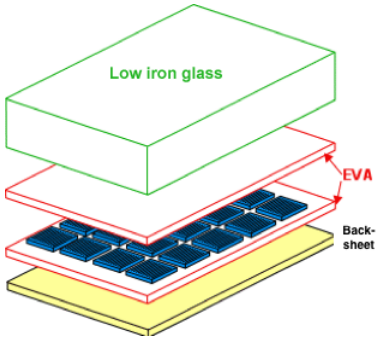
Fig. 1. Layers of solar module